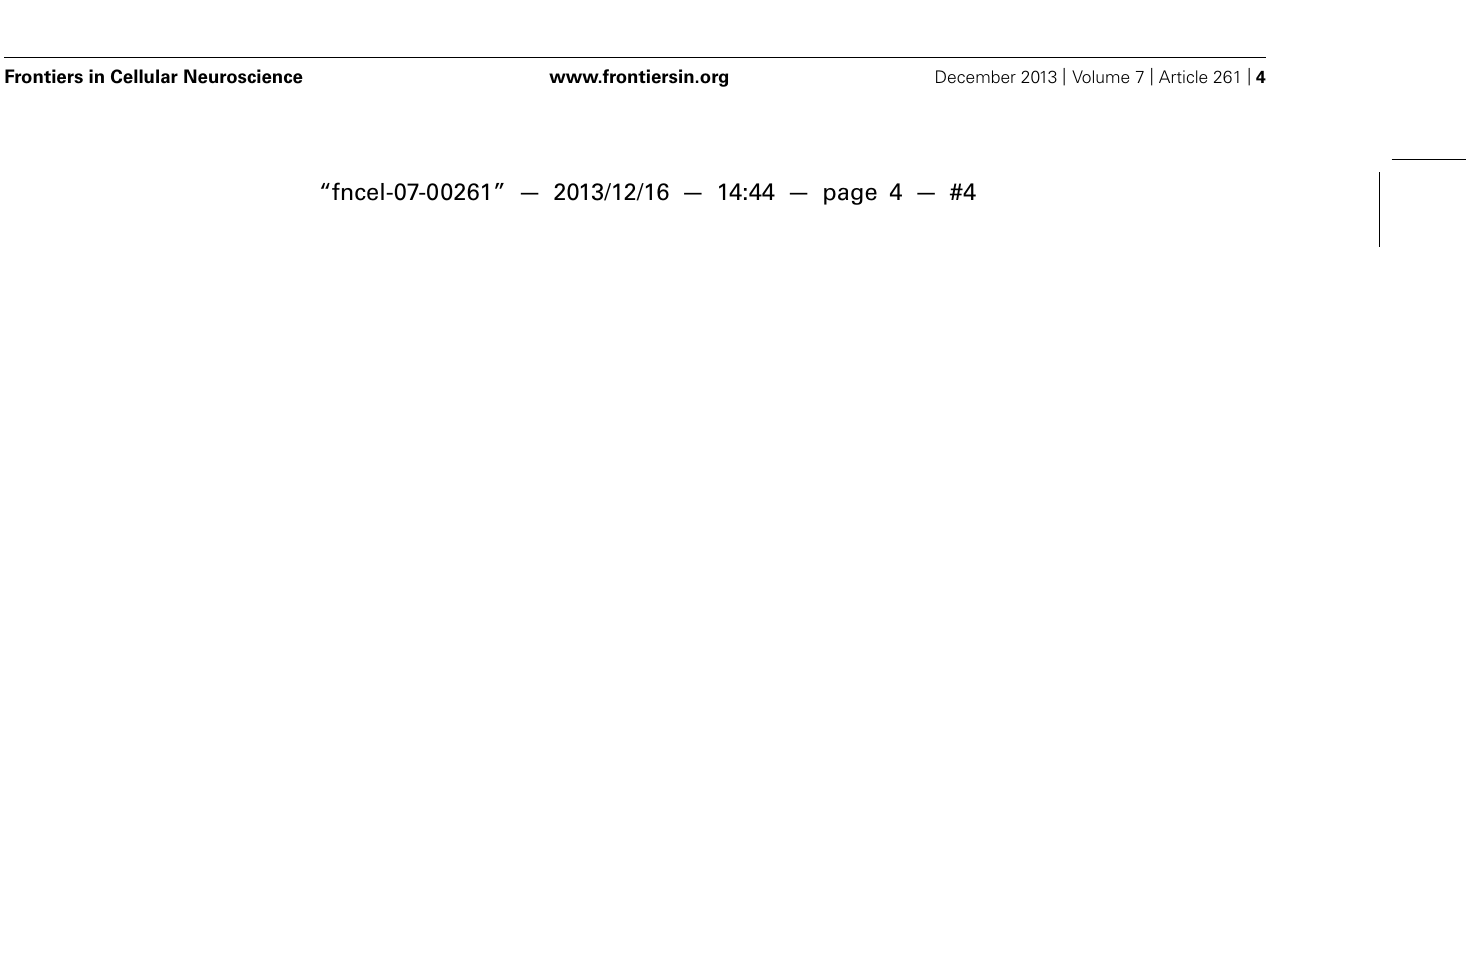
FIGURE 3 | (A) cDNA from pre-differentiated neurospheres was analyzed by quantitative RT-PCR with primers for NOX1–2 and 4. Quantification was calculated as (cid:2)(cid:2) Dc t relative values. Bar graphs represent the mean of four different experiments. (B) Neurospheres were differentiated to oligodendrocyte for three days in the presence of 100 μ M NMDA and 50 μ M MK801. Cells were fixed, immunostained with O4 (red) and p67phox (green). Bar = 5 μ m. Analysis of